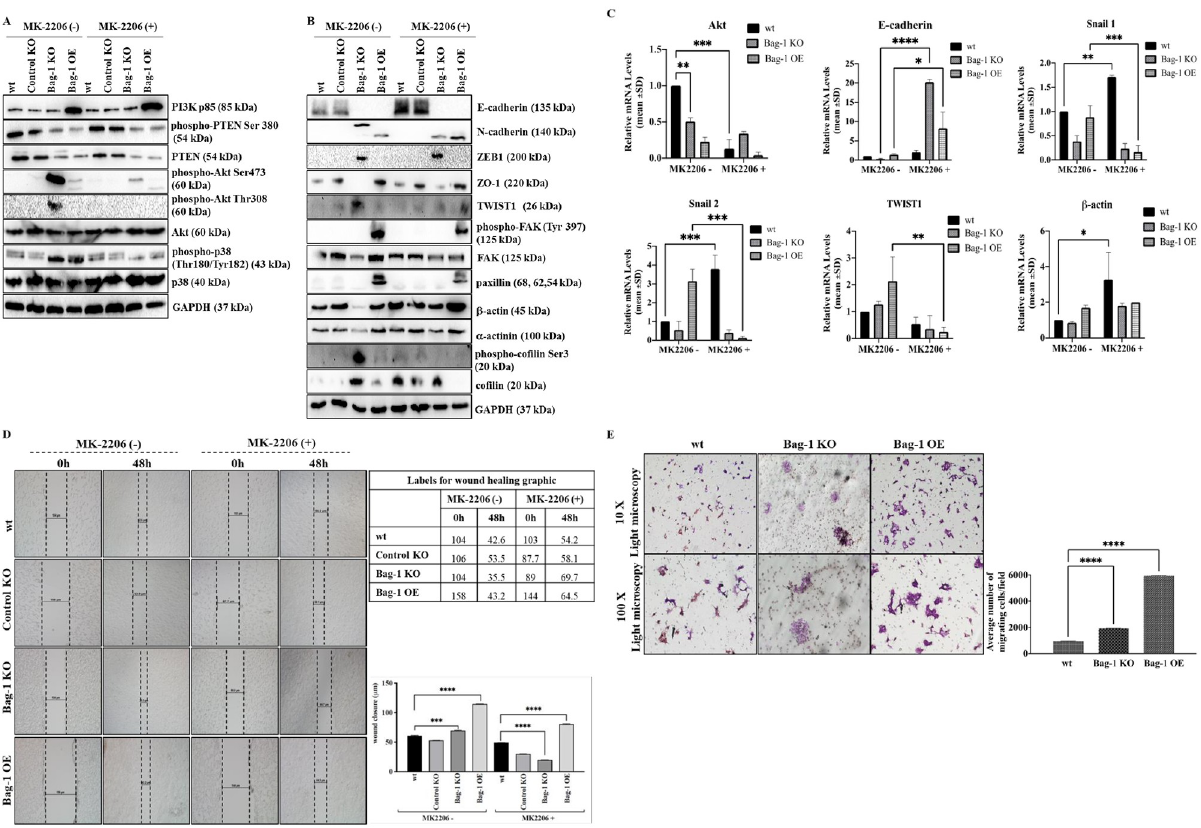
Fig 4. Investigation of the role of different Bag-1 expression levels on Akt, EMT, and focal adhesion pathways in MCF-7 cells, in association with their migration and invasion potential. Expression profiles of Akt signaling pathway members (A) and EMT, focal adhesion kinase pathway members (B) were investigated after MK-2206 treatment in MCF-7 wt, Control KO, Bag-1 KO and Bag-1 OE cells determined by immunoblotting assay. Densitometry analyses were shown in S4D and S4E Fig. The relative densitometry analysis represented the mean ± SD of three independent experiments. GAPDH was used as a loading control. ( � p = 0.0114, �� p = 0.0013, ��� p = 0.0006, ���� p < 0.0001 by Two-way ANOVA, Tukey’s multiple comparison test). C) The transcriptional level of Akt, E-cadherin, Snail1, Snail2, TWIST1, and β -actin were detected in qRT-PCR analysis. All data collected from three independent experiments (Akt �� = 0.0040, ��� p = 0.0002, E-cadherin ���� p < 0.0001, � p = 0.0317, Snail1 �� p = 0.0021, ��� p = 0.0007, Snail2 ��� p = 0.0002, TWIST1 �� p = 0.0089, β -actin � p = 0.0114. The designed primer sequences were shown in S2 Table. D) The effect of Bag-1 expression on cell migration of MCF-7 cells was assessed by wound healing assay, which was repeated by two-independent assays. Wound closure was imaged by light microscopy (magnification 4x, scale 10 μ m), and analyzed by Two-way ANOVA, Tukey’s multiple comparison test, ���� p < 00001. E) The invasion capacities of wt, Bag-1 KO and Bag-1 OE cells were determined by transwell migration assay. Left panel, invading cells (magnification x10 and x100); right panel, quantification on average number of migrating wt, Bag-1 KO and Bag-1 OE cells per well ( ���� p < 0.0001), counted by Image J and analyzed by One-way ANOVA, Dunnet’s multiple comparison test. The counted cell population was shown in S4H Fig as red stained dots.